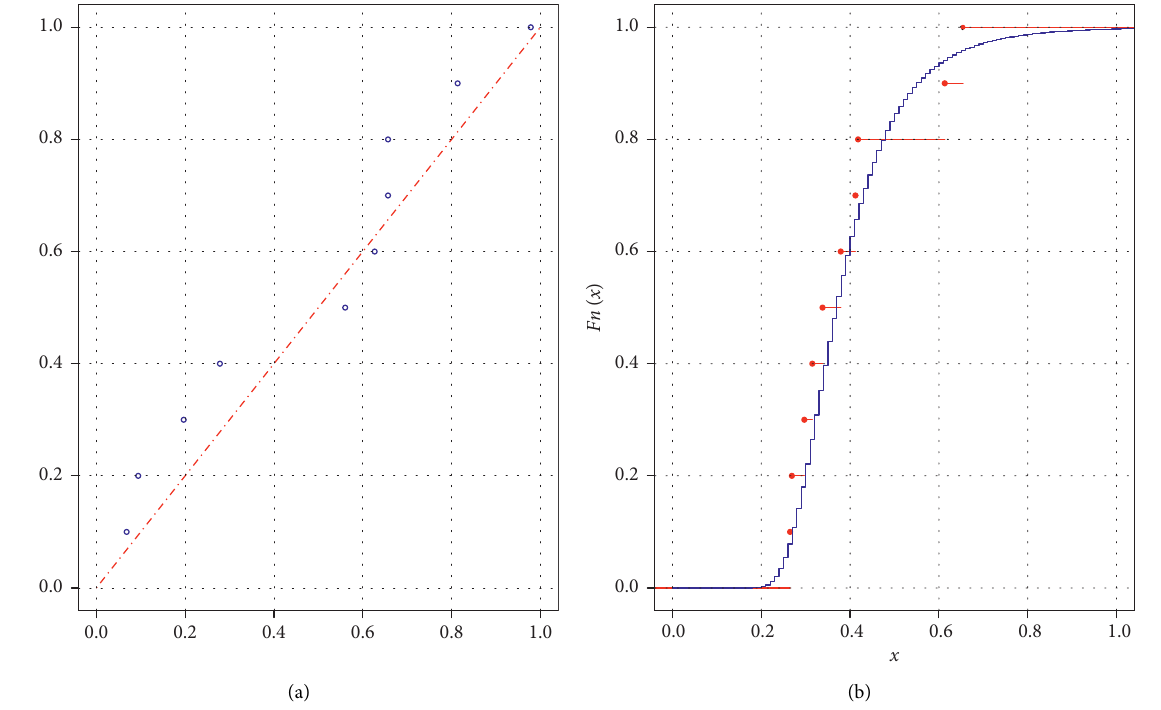
Figure 2: QQ plot and CDF of the real data set II on the EPL